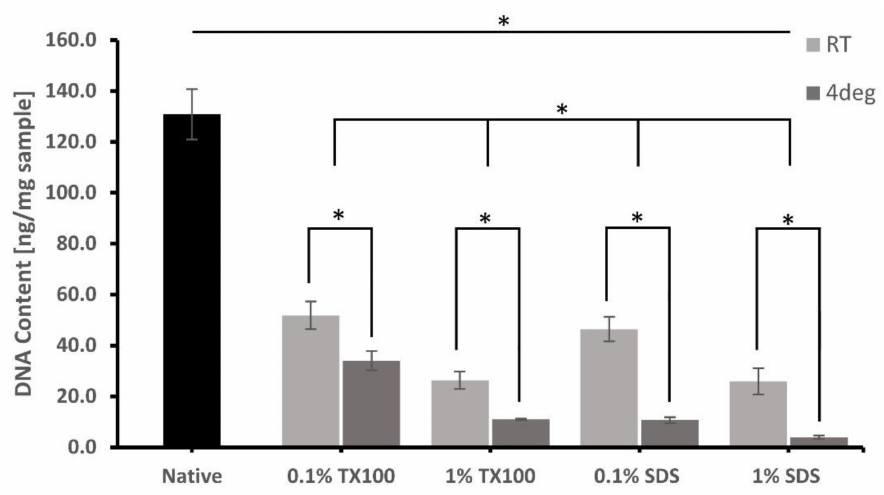
Figure 2. Comparative DNA quantification (ng/mg of the dry sample) of native milkfish skin and decellularized ECM developed from the different conditions. Bars represent standard deviation ( n = 3). * p < 0.05.